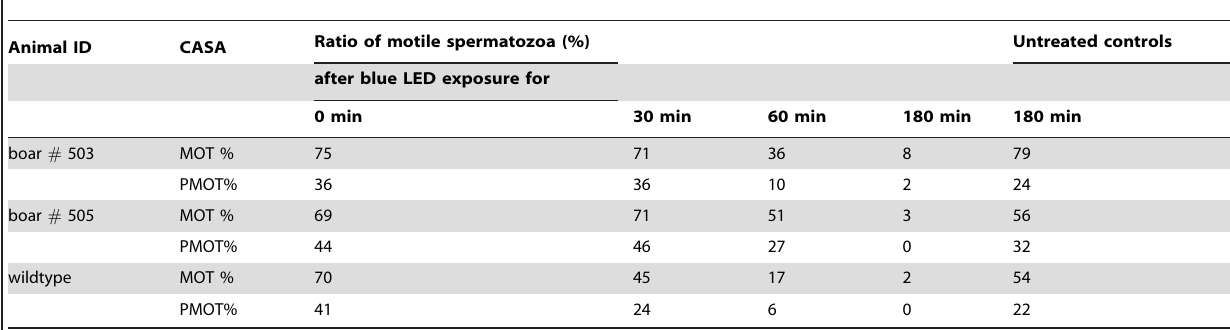
Table 4. Effects of Venus excitation on sperm motility.